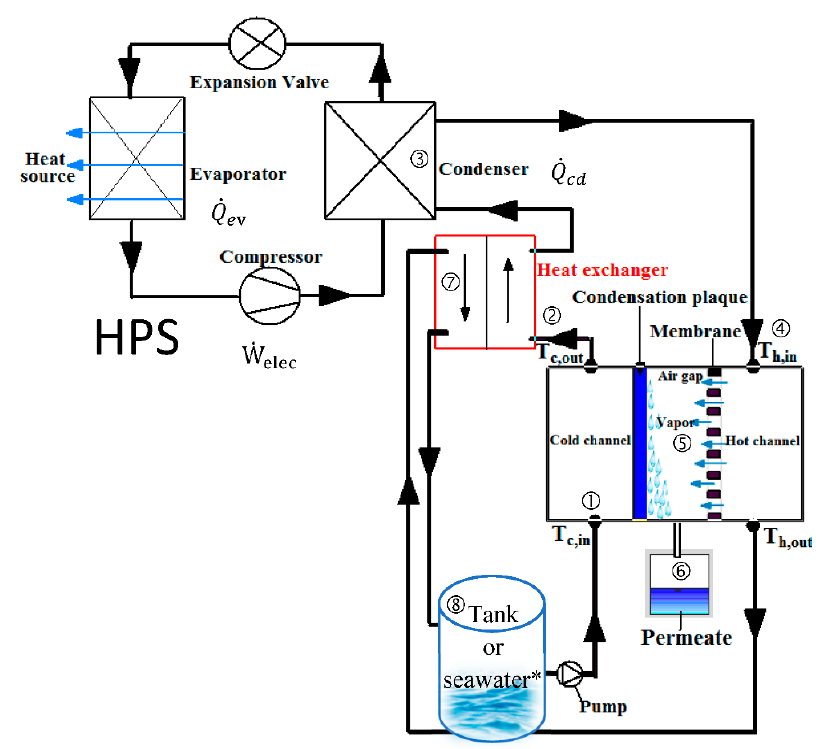
Figure 25. Schematic diagram of a HPS coupled to a membrane distillation unit. Table 13. Comparison of heat pumps for simultaneous cooling and desalination operating with HFO R1234yf, propane and CO